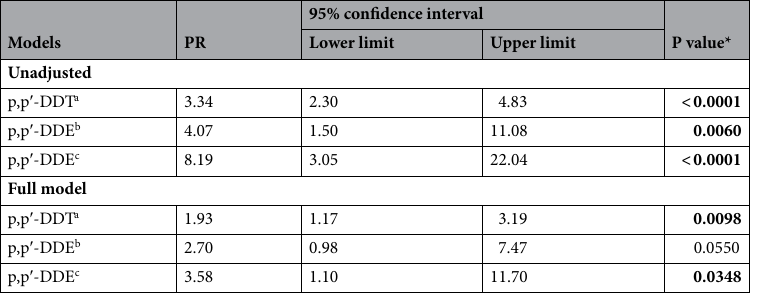
Table 3. Multivariable adjusted prevalence ratios (95% Confidence Intervals) for prevalent type 2 diabetes mellitus and p,p ′ -DDT (Dichlorodiphenyltrichloroethane) and p,p ′ -DDE (Dichlorodiphenyldichloroethylene) among adult females over 20 years of age using data from the Nituuchischaayihtitaau Aschii —Multi- Community Environment-and-Health Study (2005–2009). PR, prevalence ratio. *Significant values are in bold (p-value < 0.05). Full Model: adjusted for age, lipids, BMI, smoking status, education, parity. Significant values are in bold. a ≥ 10% detectable exposure group compared to below the limit of detection. b 25–75% tertial exposure group compared to < 25% tertial exposure group. c ≥ 75% tertial exposure group compared to < 25% tertial exposure